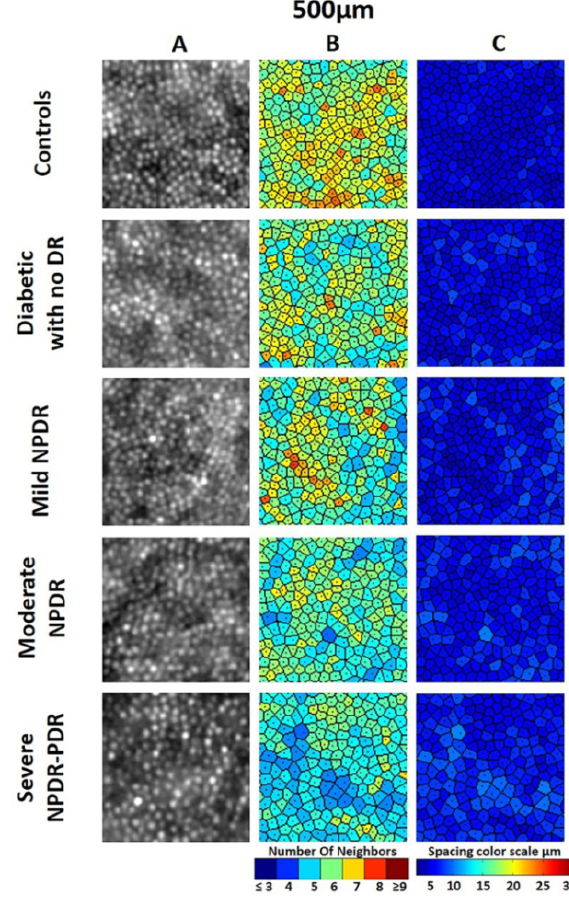
Figure 4. Images of parafoveal cone mosaic at 500 μ m eccentricity representative of each study group. ( A ) AO image of the cone mosaic in 100 μ m × 100 μ m sampling window. ( B ) Corresponding color map of Voronoi tiles. ( C ) Corresponding cone map. DR, PDR and NPDR represent diabetic retinopathy, proliferative diabetic retinopathy and nonproliferative diabetic retinopathy, respectively (Reprinted with permission from Ref. [49]. Copyright 2016, Soliman et al.).